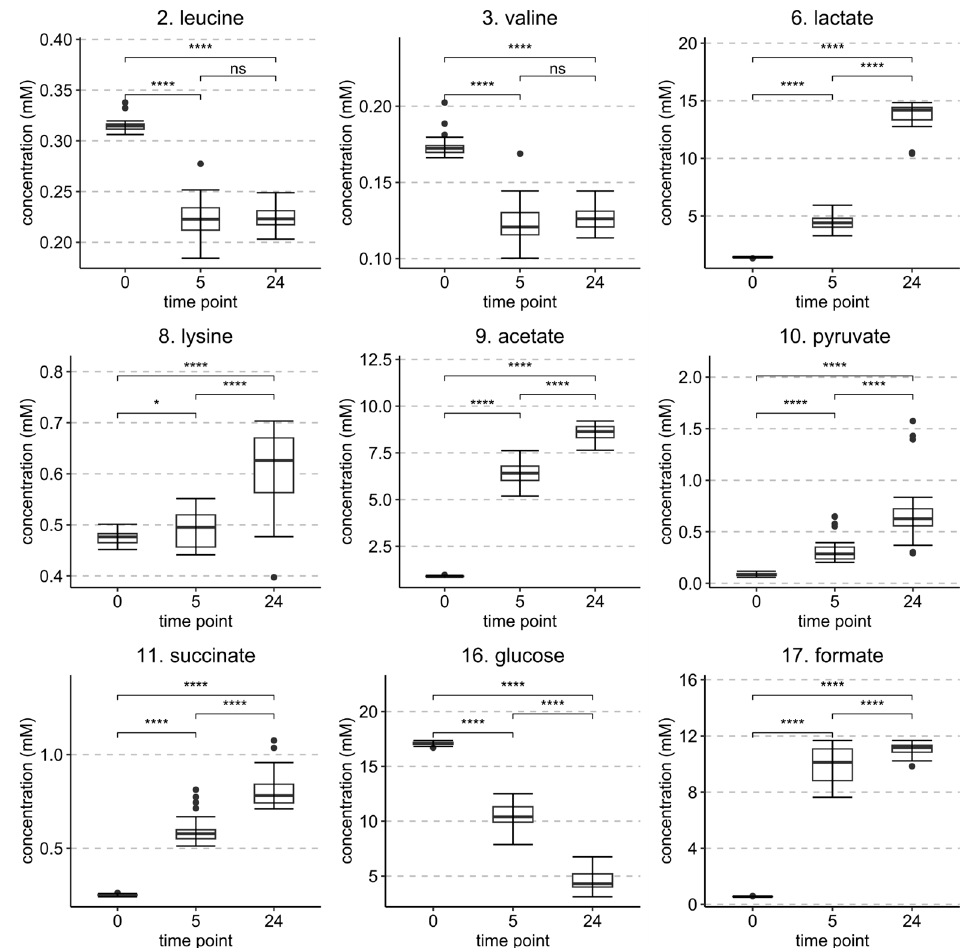
Figure 4. S tatistically significant ( p < 0.05) identified metabolites and their concentrations from the E. coli sample set at 0 h, 5 h, and 24 h time points. Metabolites are numbered according to Table 1. p values of difference are from a paired t-test (n = 30). Levels of significance: **** p < 0.0001; * p < 0.05; ns = non-significant.